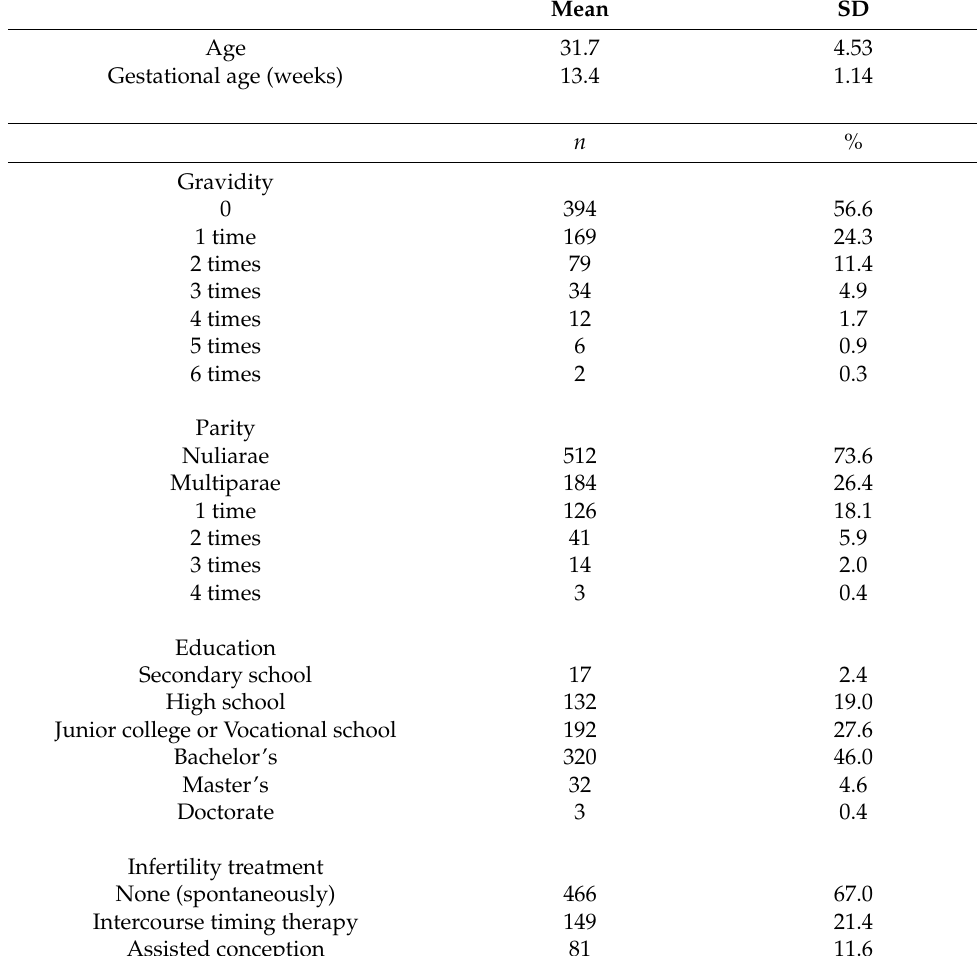
Table 1. Demographic characteristics ( n =